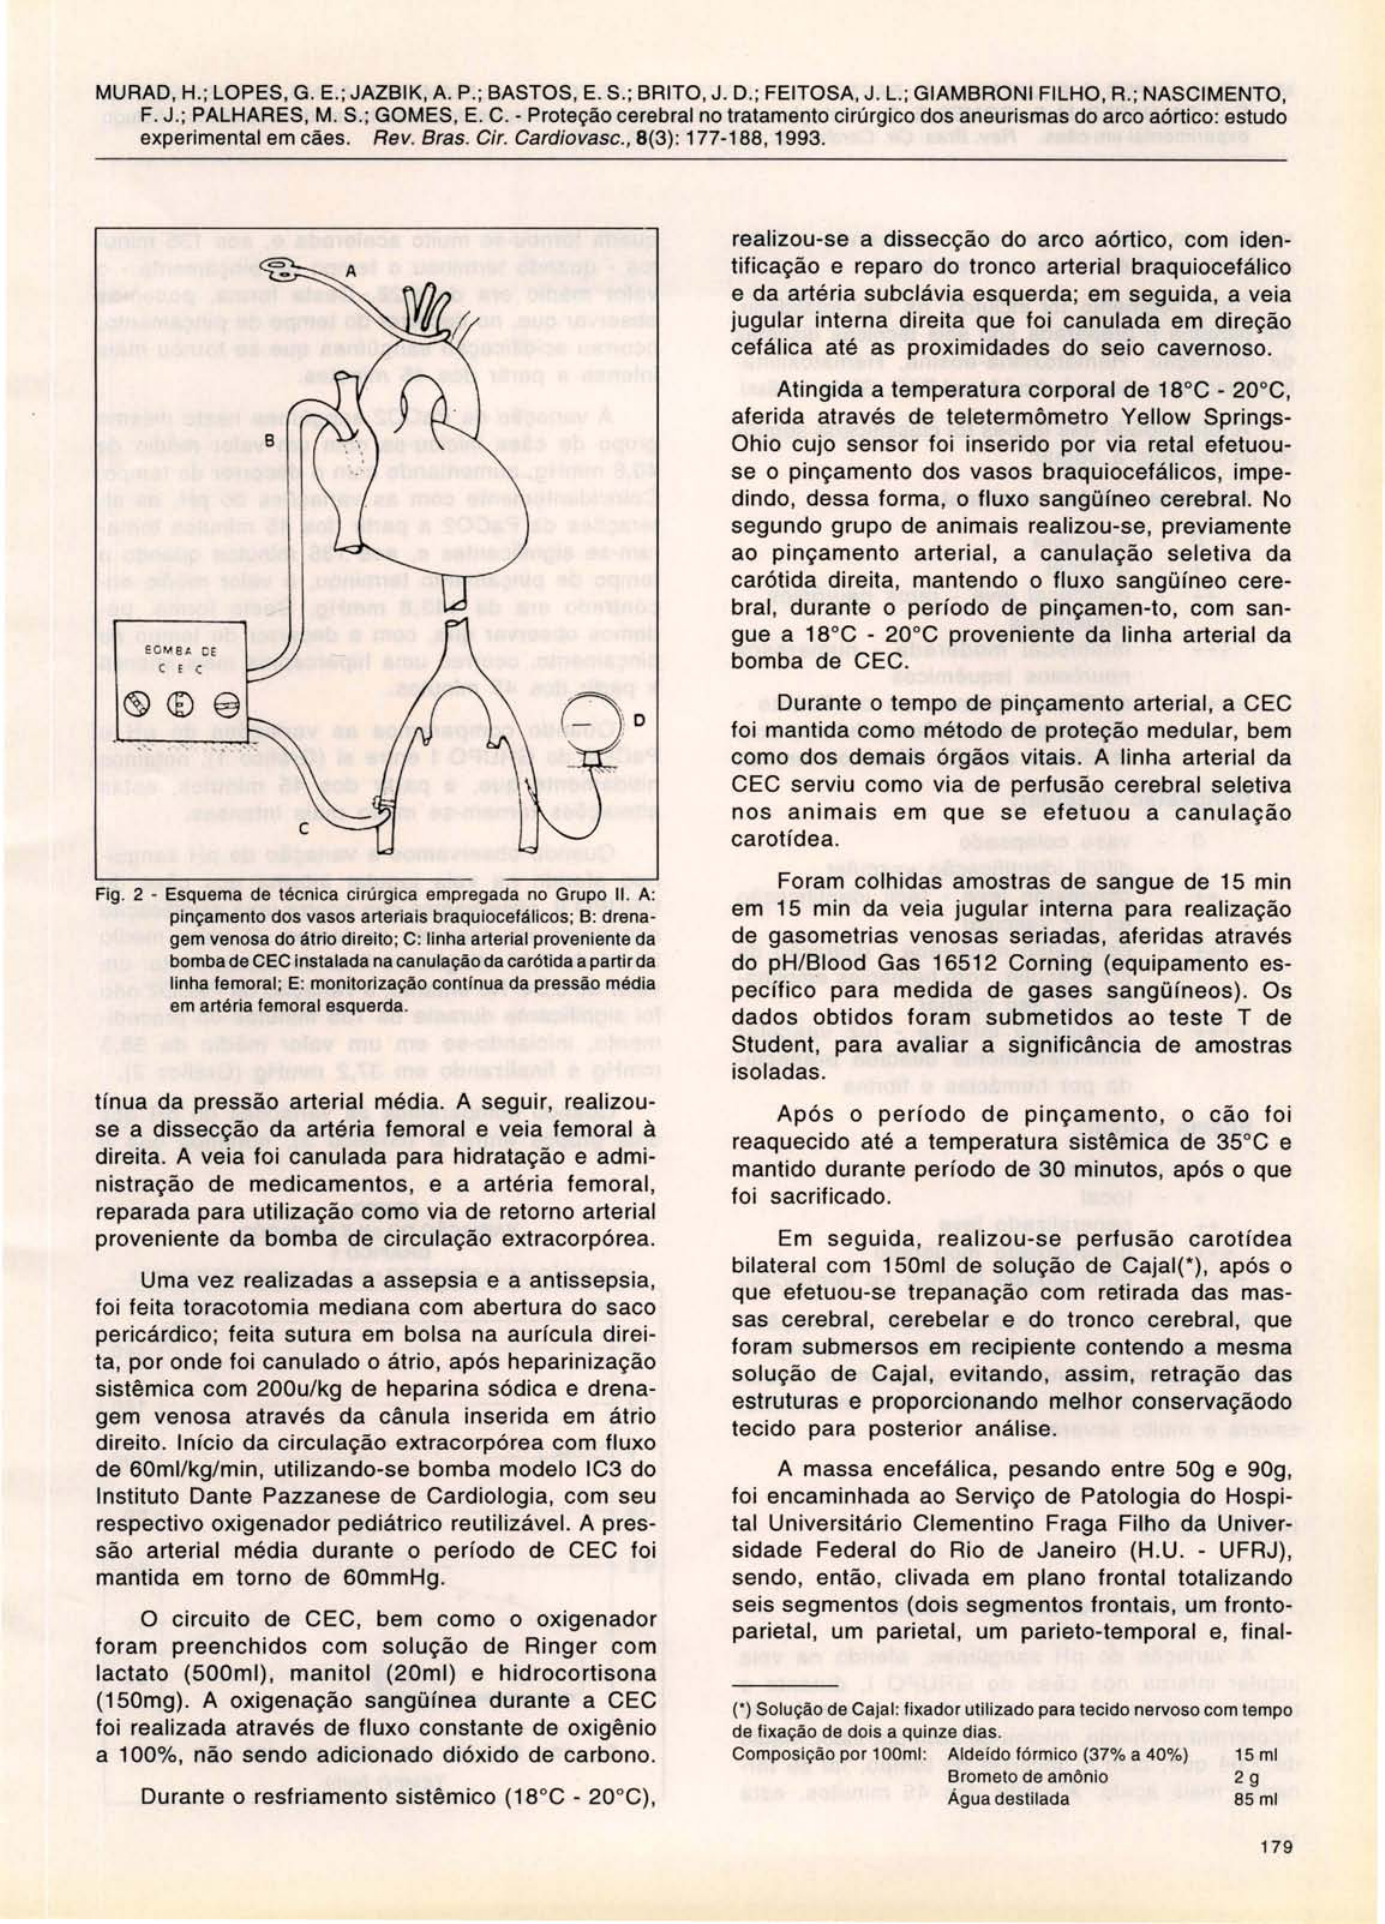
Fig. 2 - Esquema de técnica cirúrgica empregada no Grupo II. A: pinçamento dos vasos arteriais braquiocefálicos; B: